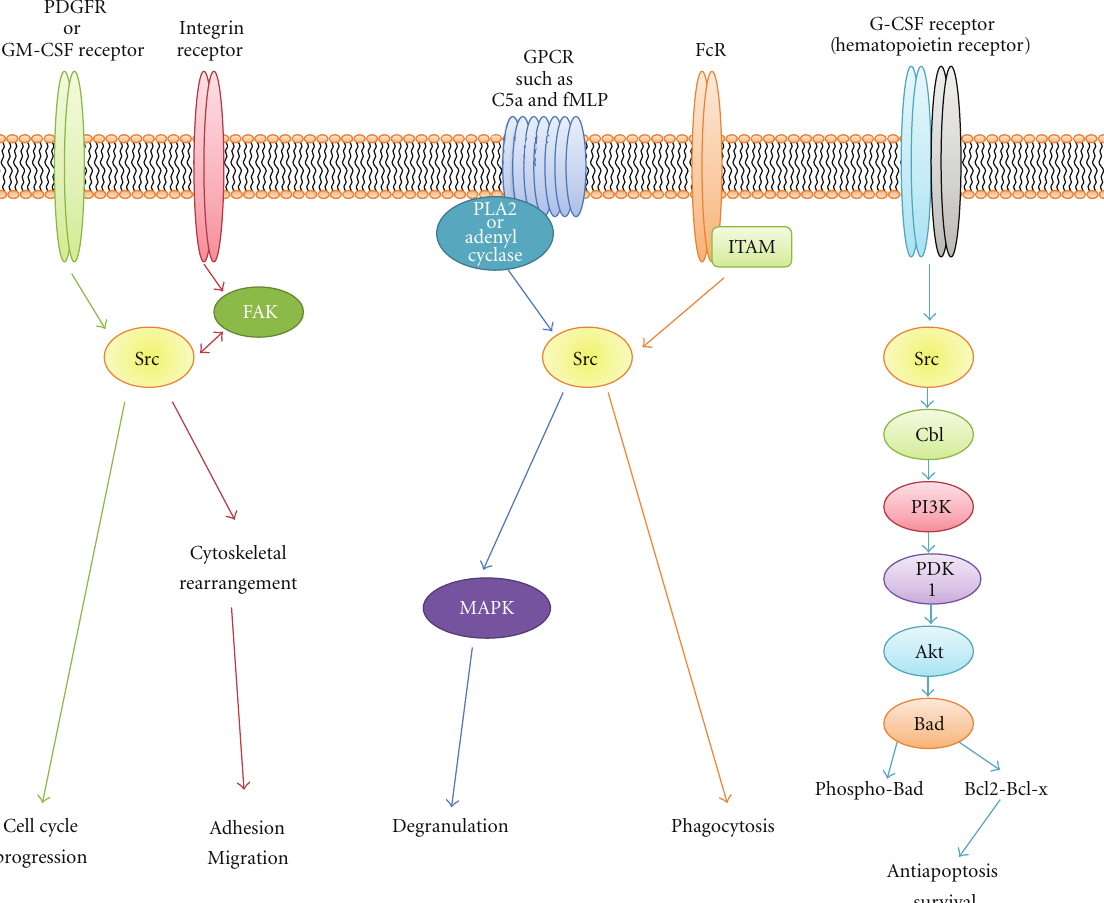
Figure 3: The role of Src in immune cells. A combination of antigens, cytokines, adhesion molecules, lipid factors, and their di ff erent receptors relevant to immune cell development and inflammatory responses. Regardless of the stimulus and the receptor type, Src plays a critical role in recruiting a number of cell signaling molecules. Initiated and activated by the receptor, Src increases and varies the signal. Depending on the signal received, multiple pathways that influence cell migration, adhesion, phagocytosis, cell cycle, and cell survival are